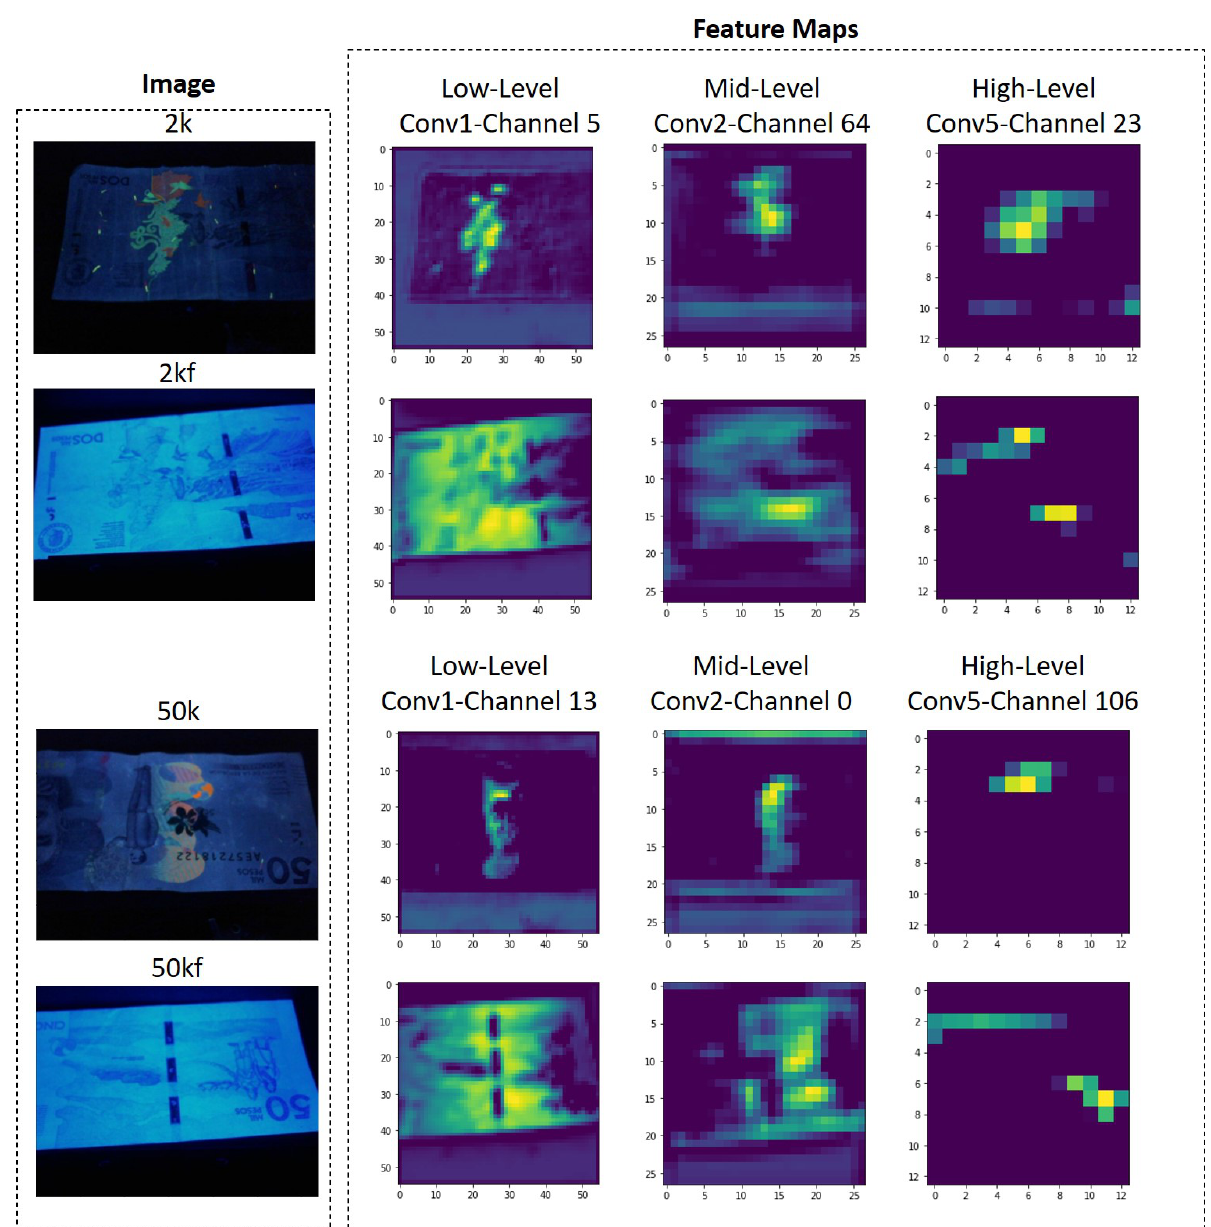
Figure 12. Example of feature maps for some banknotes (original and fake). Additionally, the filters are able to learn to differentiate the denominations of the banknotes. Figure 13 shows an example for the different denominations in the dataset, only for original banknotes. It should be noted that the feature maps of the 20k banknote on channel0 and channel125 are different in relation to other banknotes, just as the feature maps of the 50k and 100k banknotes of the channel99 differ from the other denominations. In the case of channel191, the feature map is activated not only in the UV mark, but in the